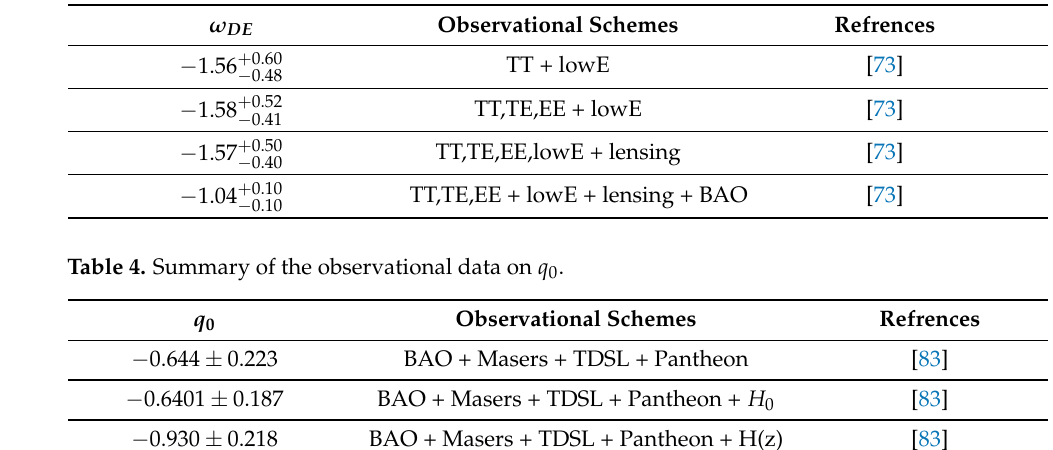
Table 3. Summary of the observational data on ω DE .